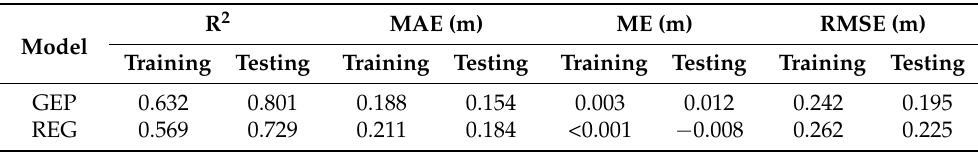
Table 4. Bathymetry retrieval accuracy of GEP and REG